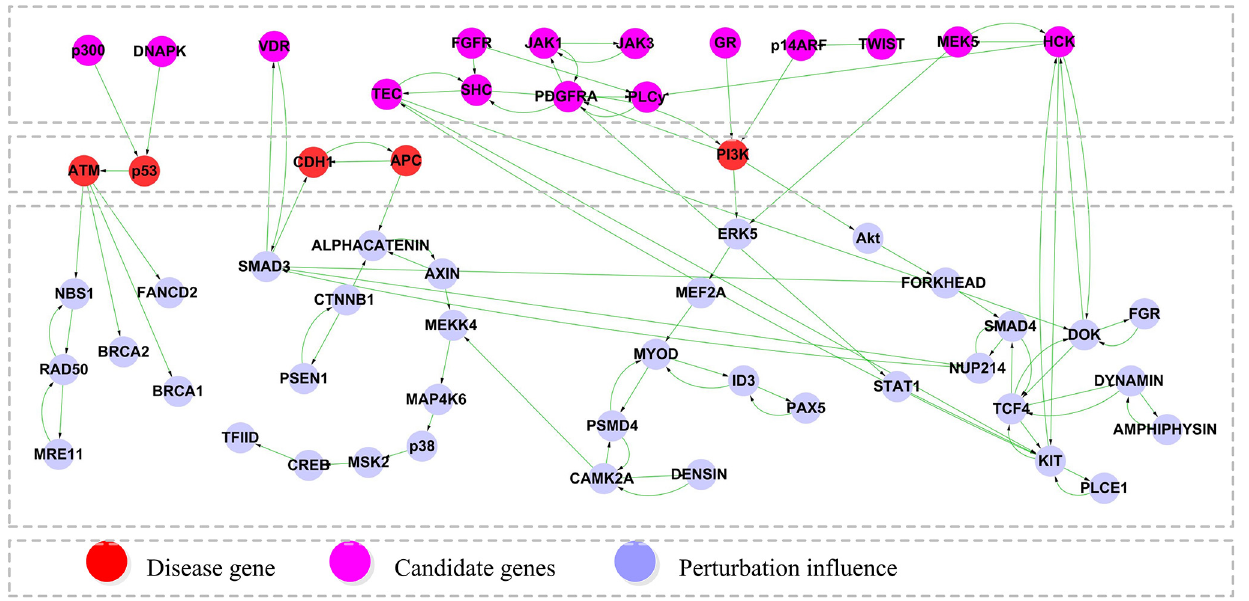
Fig 5. Sketch of prediction results for Breast cancer in Cancer Signaling Map. 5 known disease genes are highlighted by red color, 15 top ranked potential causal genes are highlighted by magenta color and the genes in the diversified control paths of disease genes are highlighted by purple